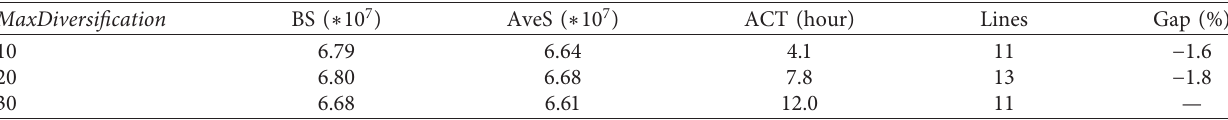
Table 8: Results for different values of MaxDiversification on the large HSR network.